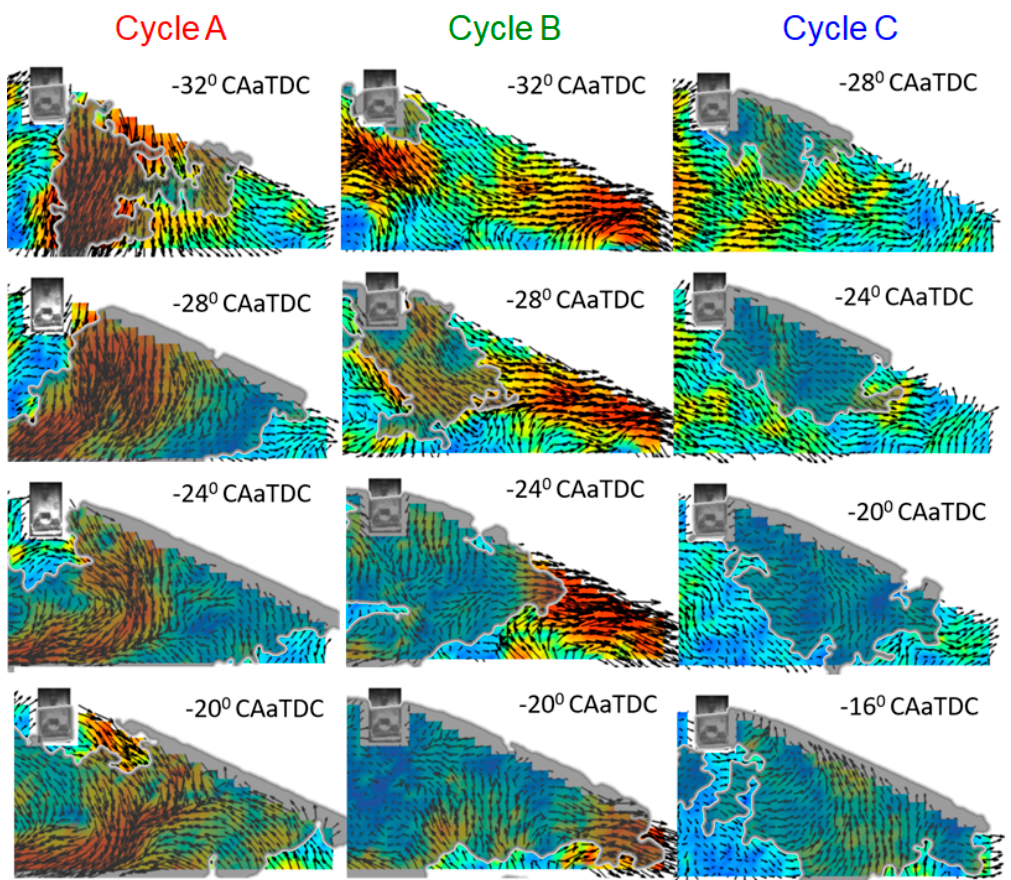
Figure 9. PIV-flame-development images after initial kernel development of three selected cycles (A, B, and C) at 1700 rpm condition.